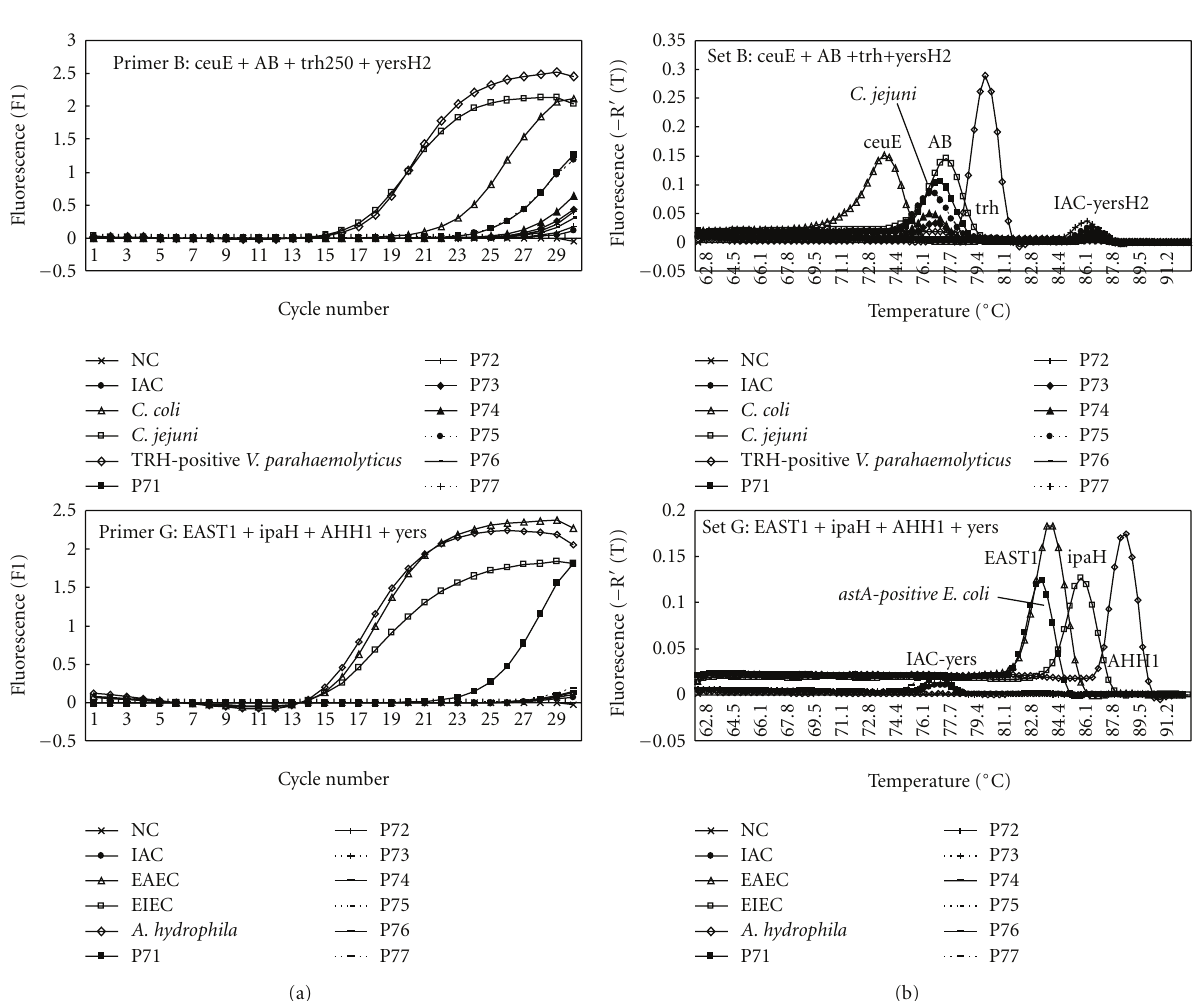
Figure 2: Melting curve analysis of multiplex real-time SG-PCR products from 7 stool samples in case 21 of a foodborne outbreak. Two panels show detection of target genes of foodborne pathogens by primer sets B and G, but it was not detected by the other 6 primer